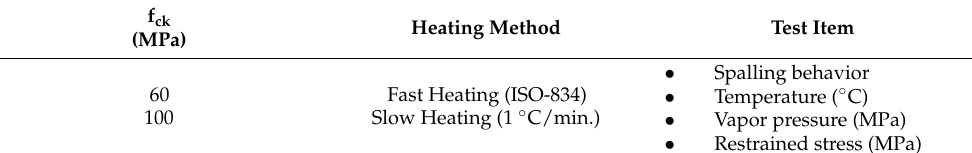
Table 1. Experimental plan for this study.